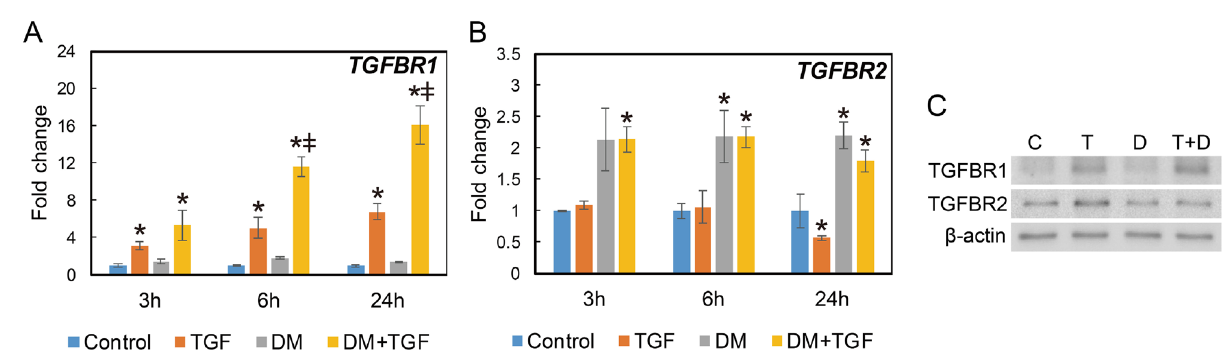
Figure 5. Expression levels of TGF-β receptors in vocal fold fibroblasts after treatment with TGF-β and dexamethasone. HVOX cells were treated with TGF-β1 (TGF-β; 10 ng/mL), dexamethasone (DM; 10 −7 M), and RU486 (RU; 10 −6 M) for 3, 6, and 24 h. TGFBR1 and TGFBR2 mRNA expression was examined by qPCR ( A , B ). Relative expression levels of each gene to GAPDH were compared with those of the control group, and are shown as mean ± SEM (n = 3). * P < 0.05 vs. control. ǂ P < 0.05 vs. TGF-β. TGFBR1 and TGFBR2 protein expression in the cells treated for 24 h were examined by Western blotting ( C